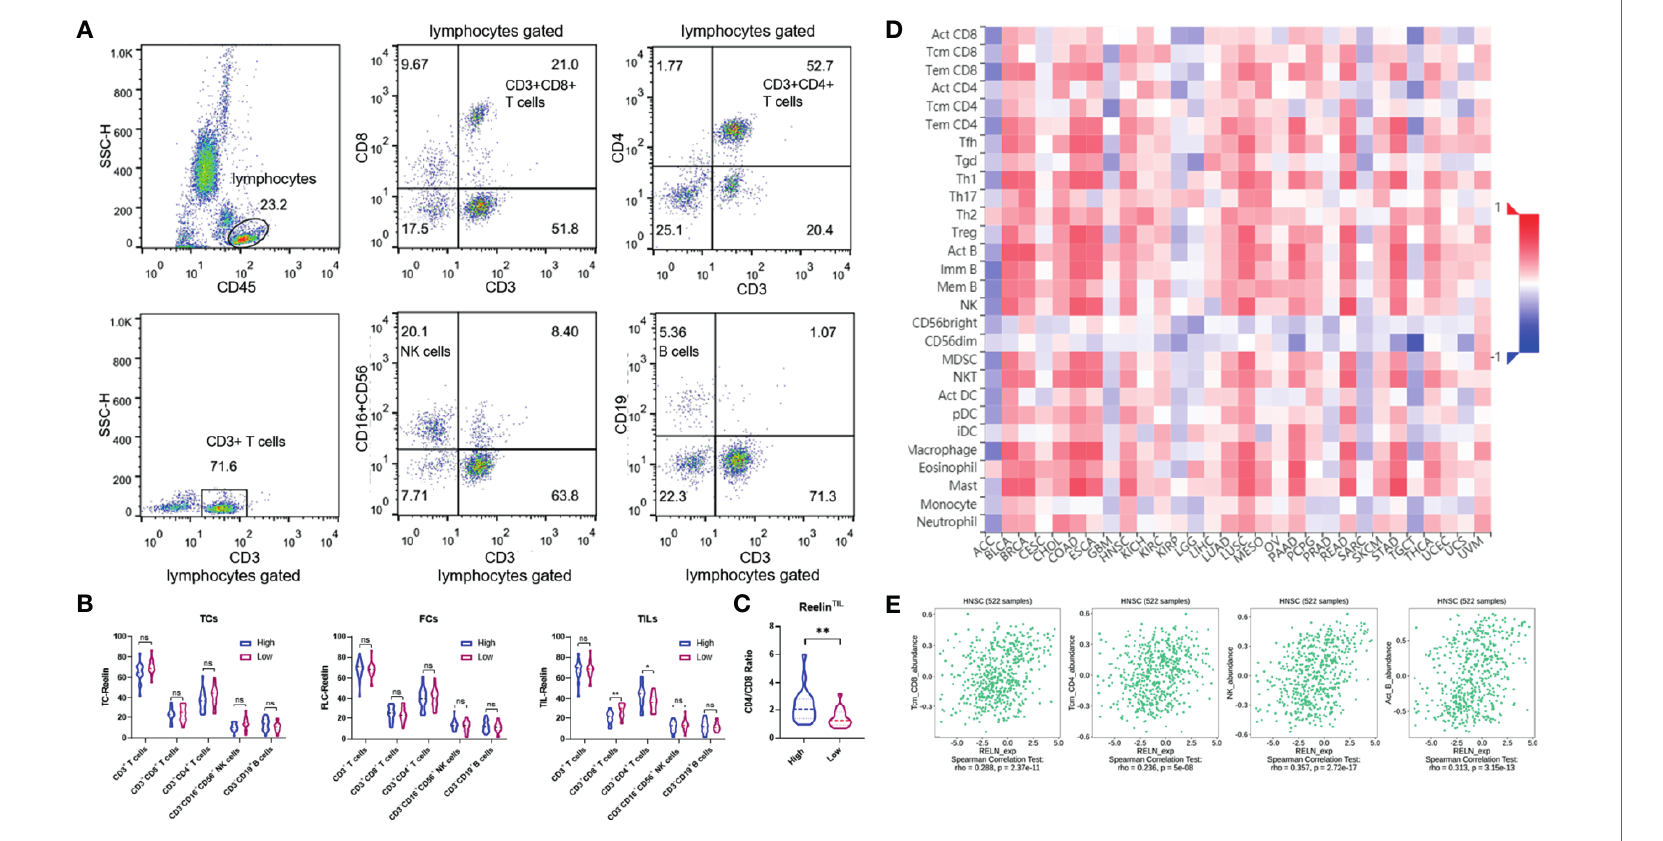
FIGURE 5 | Flow cytometry analysis of lymphocytes, gated based on characteristic light-scatter properties, and single lymphocytes were gated based on forward scatter height vs . forward scatter area (FSC-A). The numbers in the quadrants or over line indicate the percentage of cells (A) . Correlation of Reelin expression with immune in fi ltration level in OSCC before surgery, according to TCs, CAFs, and TILs (B) . Correlation of CD4/CD8 ratio with Reelin in TILs (C) . Relations between expression of RELN and 28 types of TILs across human heterogeneous cancers (D) . RELN signi fi cantly correlated with CD8 + T cells, CD4 + T cells, NK cells, and B cells in HNSCC (E) . * and ** denote that differences were considered statistically signi fi cant with p < 0.05 and p < 0.01, respectively. ns represented no statistical